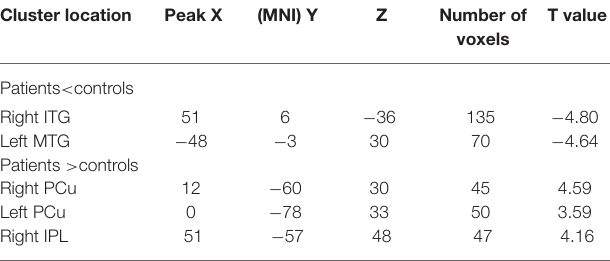
TABLE 2 | Signification differences in NH values between the groups. Cluster